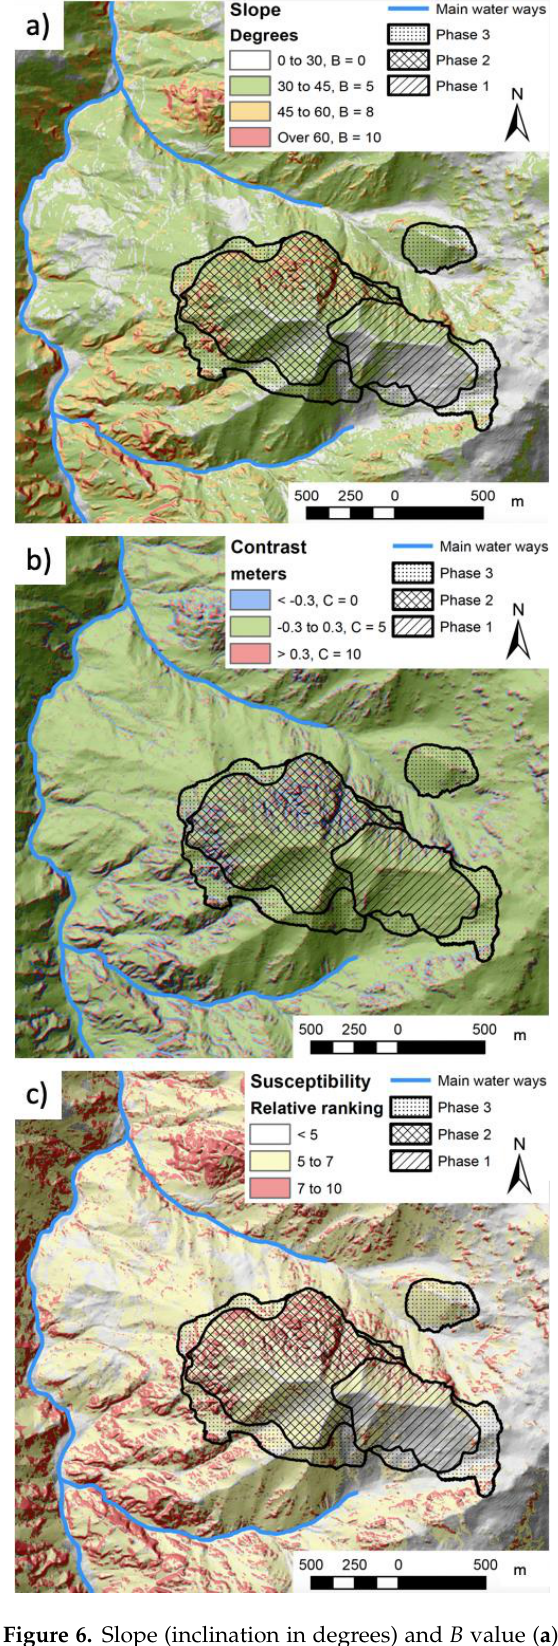
Figure 6. Slope (inclination in degrees) and B value ( a ), topographic contrast an C value ( b ), and calculated relative susceptibility to naturally occurring rockfalls (pre-mining) ( c ).